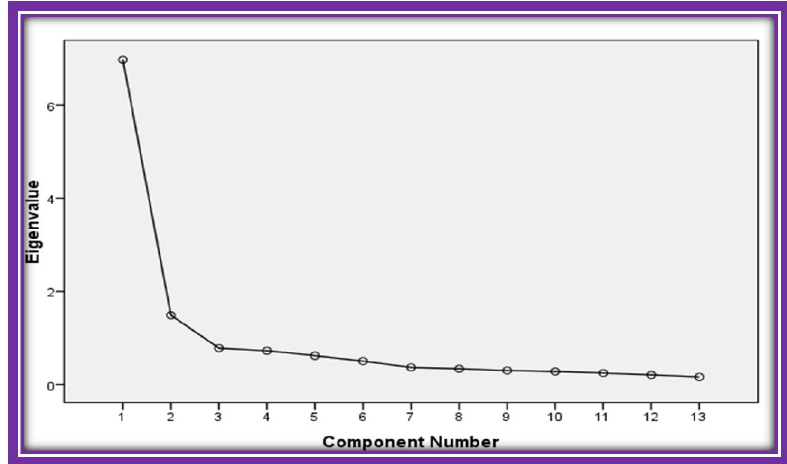
Fig. 1. The Scree plot of different factors